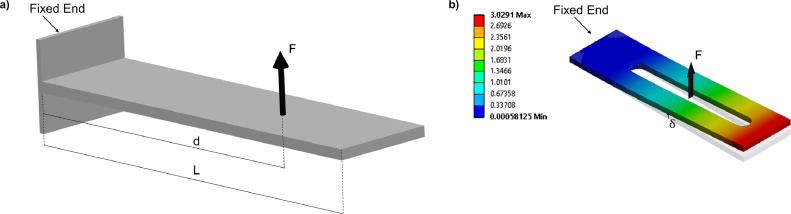
(a) Cantilever load on the support bar; (b) the respective finite element model.